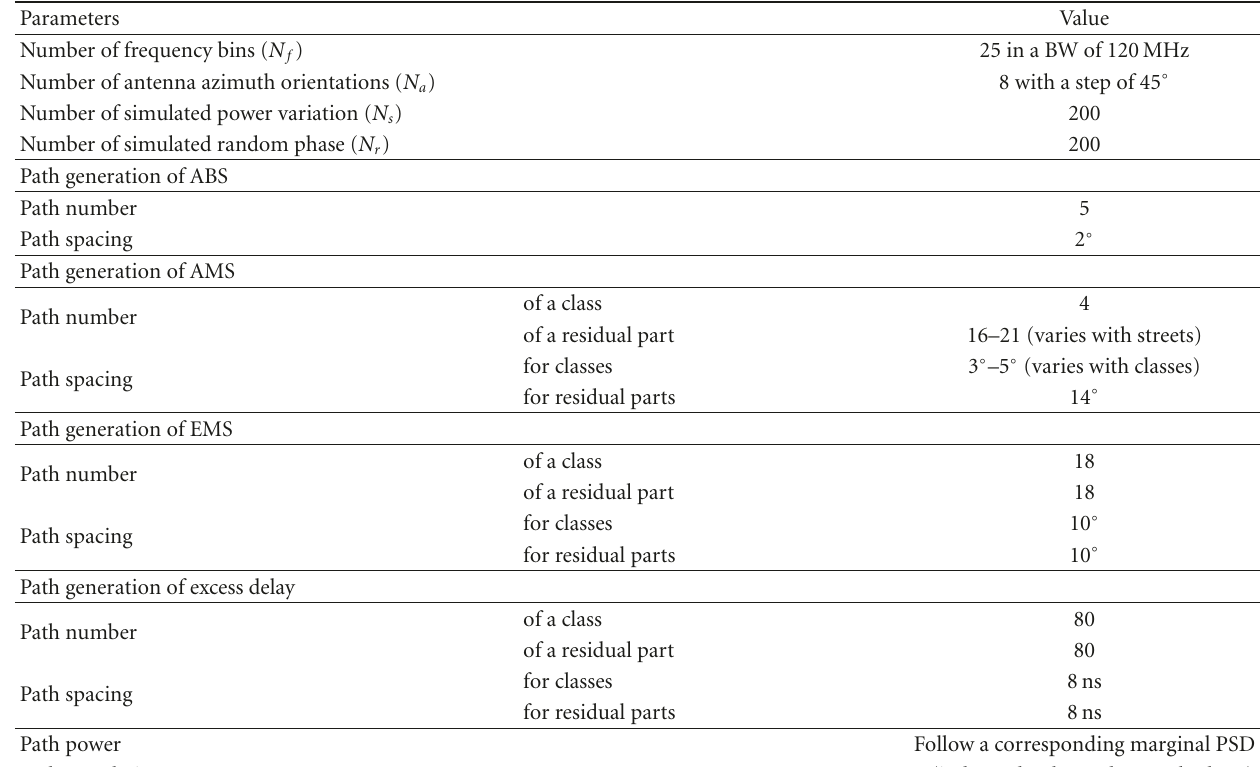
Table 5: Simulation conditions.